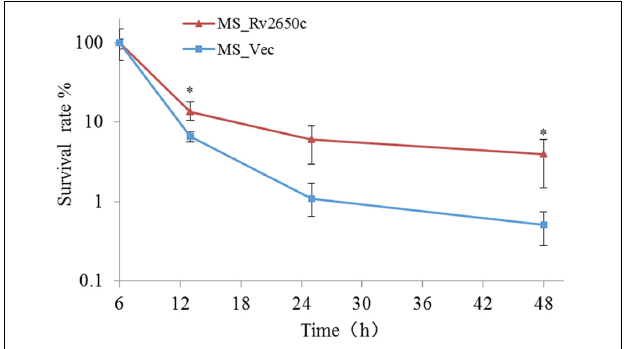
FIGURE 4 | The intracellular survival rate of macrophages infected with recombinant M. smegmatis . THP-1 cells were infected with recombinant M. smegmatis MS_Rv2650c and MS_Vec, respectively, and the cells were lysed with SDS at the corresponding time. The cell lysate was diluted and coated on MB 7H10 plate. The number of single colonies was calculated after incubation for 3–4 days at 37 ◦ C. Similar results were obtained in 3 independent experiments. (* p <